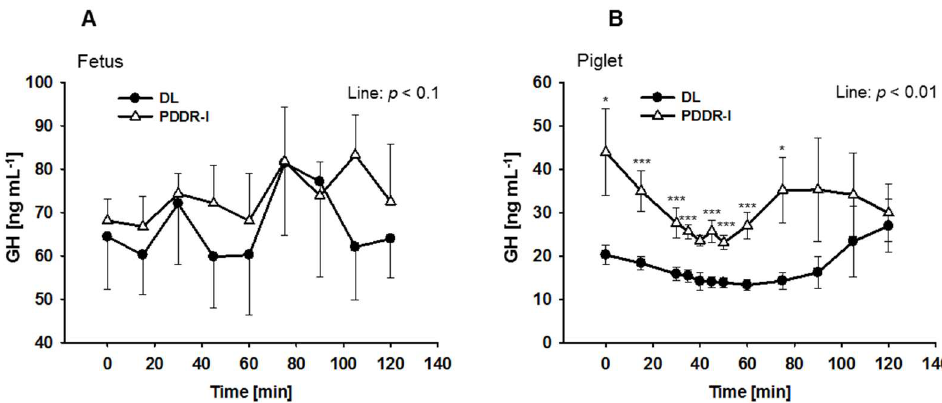
Figure 1. Growth hormone (GH) plasma concentrations in chronically catheterized German Landrace (DL) and pseudo vitamin D deficiency type I (PDDR-I) fetuses and piglets. ( A ) GH plasma concentrations in fetuses. Data represent the means of 8 blood profiles of DL ( n = 3) and the means of 14 blood profiles of PDDR-I fetuses ( n = 4). The samples were collected within 1 to 4 sampling days after catheterization. ( B ) GH plasma concentration in piglets. Piglets were catheterized at 35 days postpartum (p.p.) and blood sampling started at 37 p.p. Concentrations were higher in PDDR-I ( n = 7) vs. DL piglets ( n = 8). Sampling was performed for 120 min every 15 min in fetuses and piglets, but with a 5 min frequency between 30 min and 50 min after the start of sampling only in piglets. Data are presented as means ± standard error of mean ; * p < 0.05, *** p < 0.001. Comparing the body weight of both lines between day seven and day 42 p.p. we observed higher body weight in DL piglets ( p < 0.001) (Figure 2).